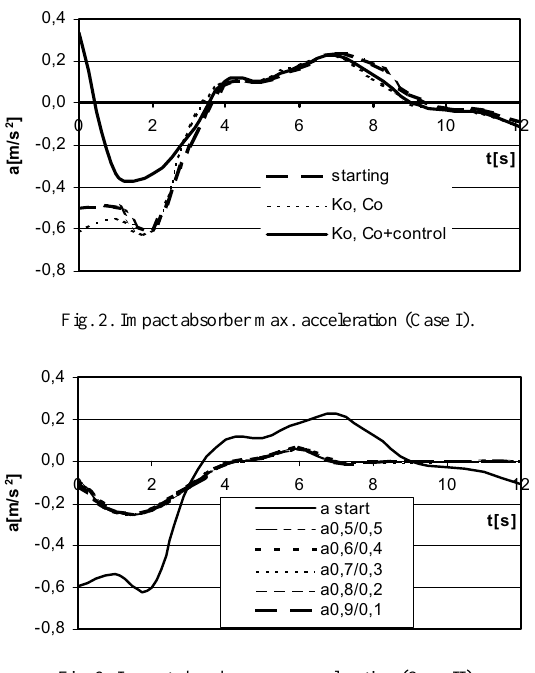
Fig. 3. Impact absorber max. acceleration (Case II).